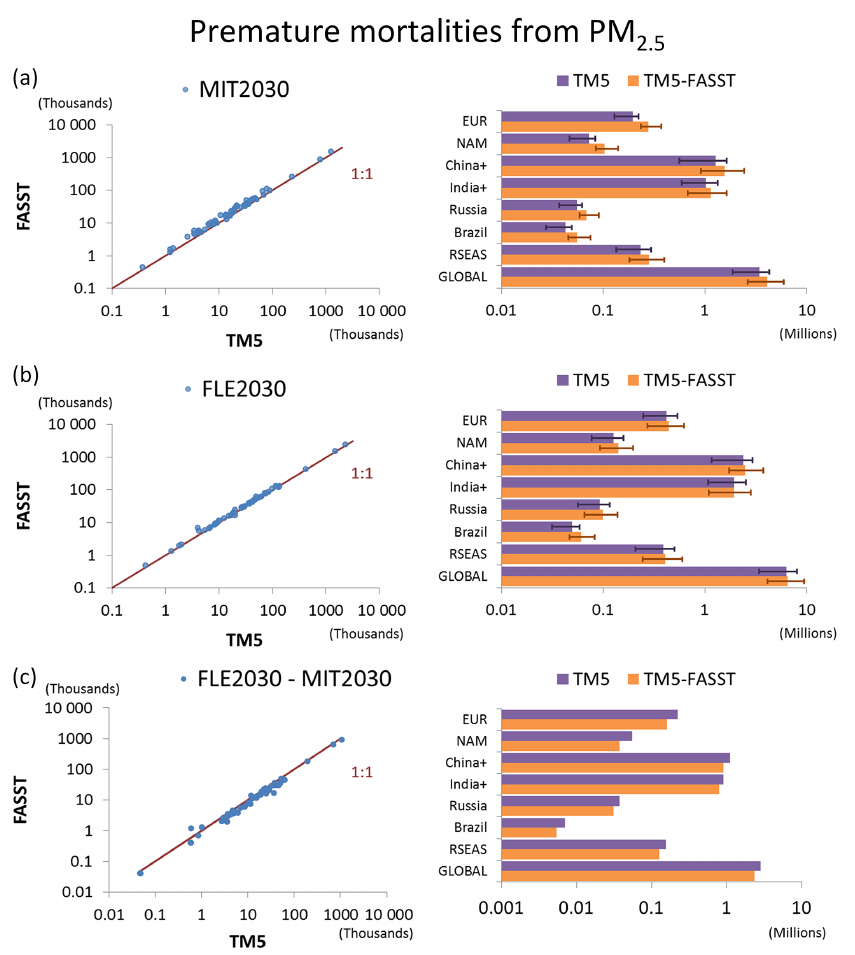
Figure 12. FASST versus TM5 premature mortalities from exposure to PM 2 . 5 for MIT2030 (a) and FLE2030 (b) scenarios and the delta between both (c) . Dots show values aggregated over each FASST region. Bar plots show totals for selected world regions and the global total. Error bars represent the 95% CI on the RR from the exposure-response function (by Burnett et al.,